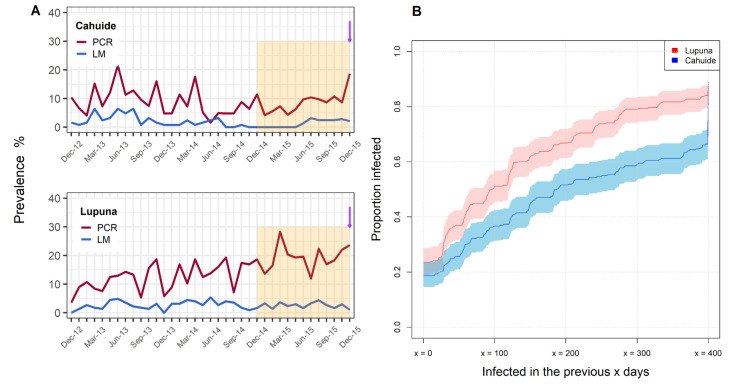
Prevalence of P. vivax infection in the Peruvian cohort.(A) Longitudinal prevalence of P. vivax infection by light microscopy or PCR in Cahuide and Lupuna. Retrospective analyses were performed using infection history over the last year of follow-up, which is indicated by the orange shadow. The purple arrow indicates when antibodies were measured. (B) Proportion of individuals with PCR-detectable infection in the previous “x” days the end of follow up. Shaded areas represent the respective 95% confidence intervals.